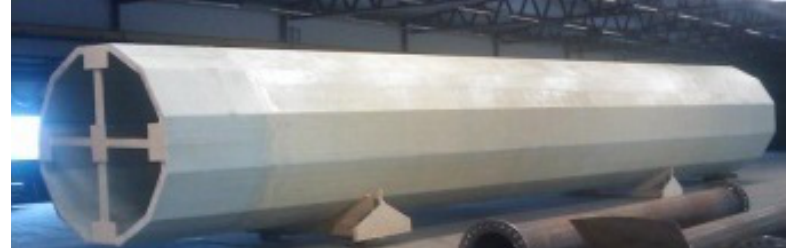
Figure 4. A 12-sided tower segment of the wooden tower for the 200 kW turbine.